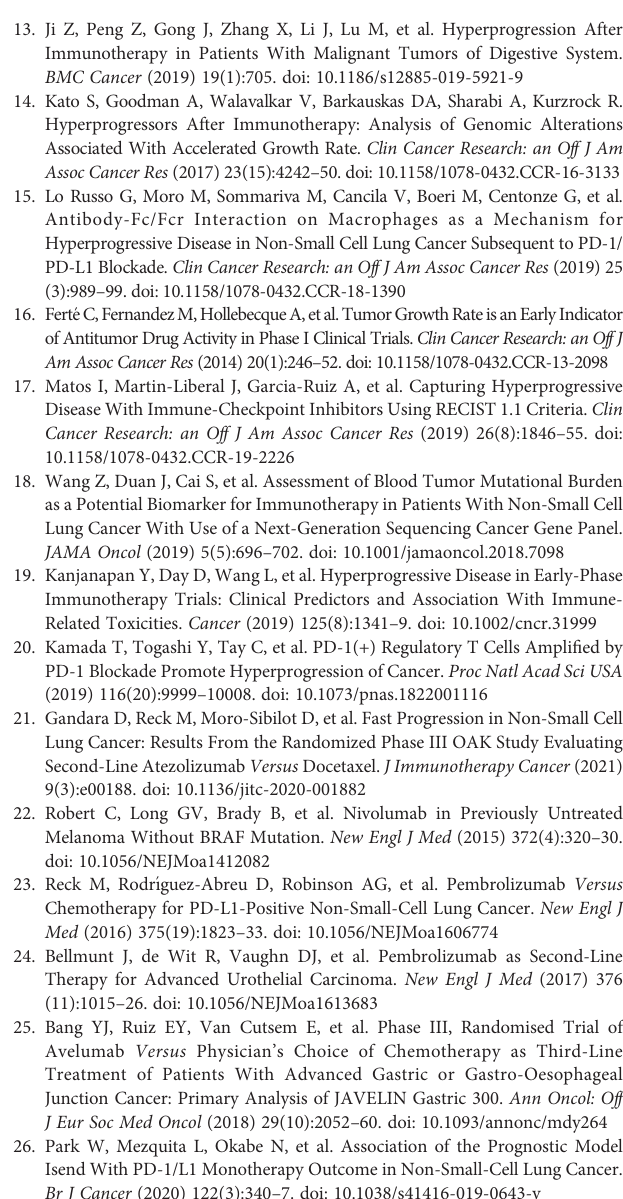
Supplementary Figure 2 | Kaplan-Meier plot of overall survival (OS) between subgroups of discordant HPD, concordant HPD, and non-HPD progressive disease when including new lesions into the calculation of tumor growth or not. HPD, hyperprogressive disease; PD, progressive disease. Supplementary Figure 3 | Genomic alterations from NGS analysis with ctDNA derived from blood samples collected prior ICI treatment. NGS, next-generation sequencing; ctDNA, circulating tumor DNA; ICI, immune checkpoint inhibitors; HPD, hyperprogressive disease; PD, progressive disease; dMMR, mismatch repair de fi cient; MSI-H, microsatellite